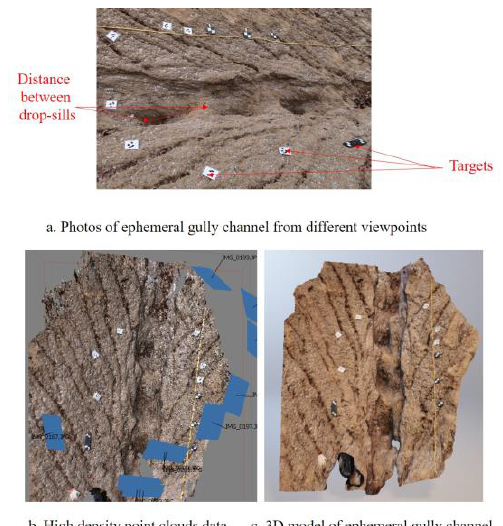
Figure 4 Ephemeral gully channel measured by photogrammetry